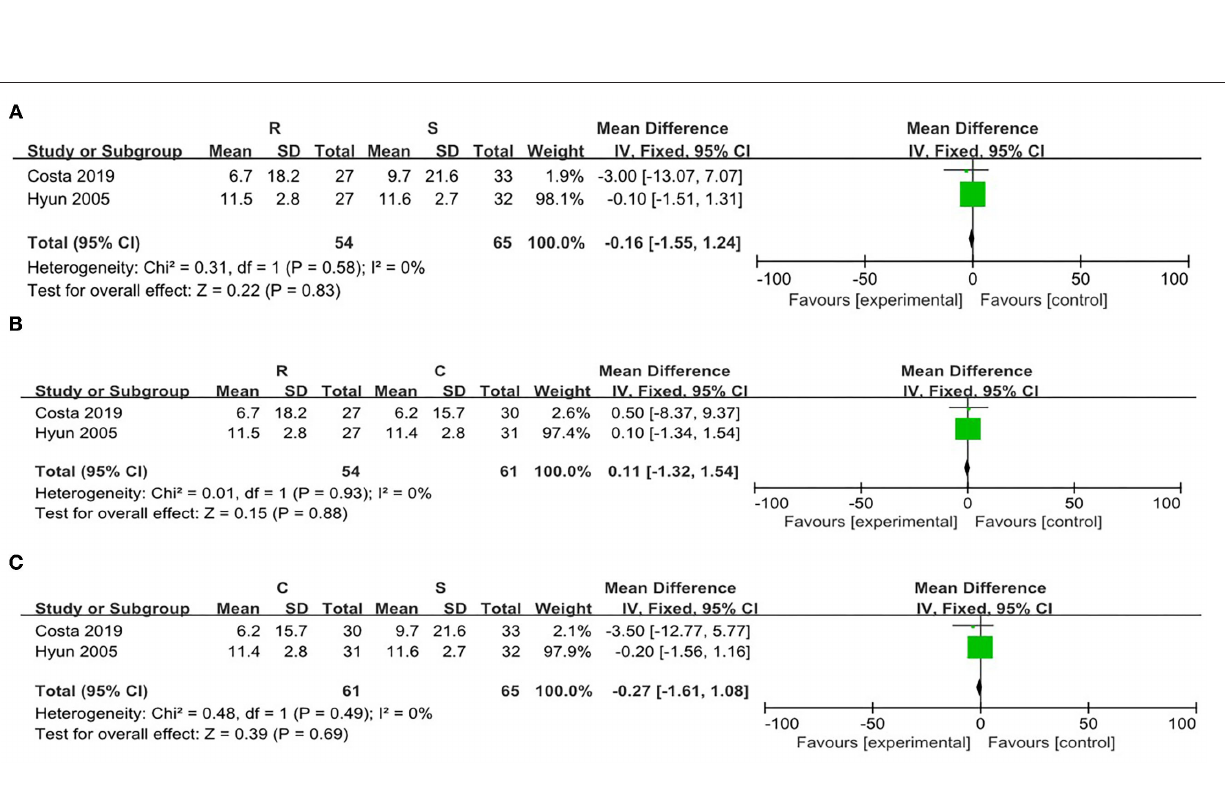
FIGURE 6 | Risk evaluation for the bias of the literatures at T2. (A) CRP vs. SRP; (B) RRP vs SRP; (C) RRP vs. CRP.